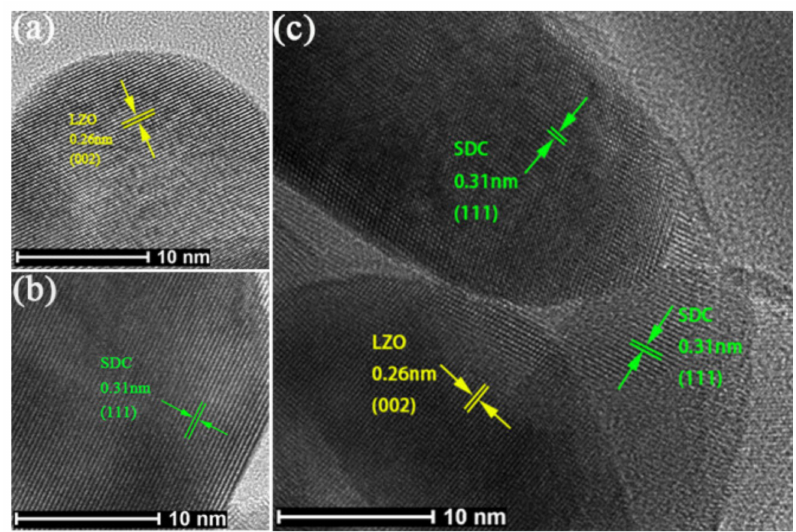
Figure 8. HR-TEM images showing the grains of ( a ) LZO and ( b ) SDC with well-defined crystalline lattice; ( c ) a typical hetero-interface between LZO and SDC